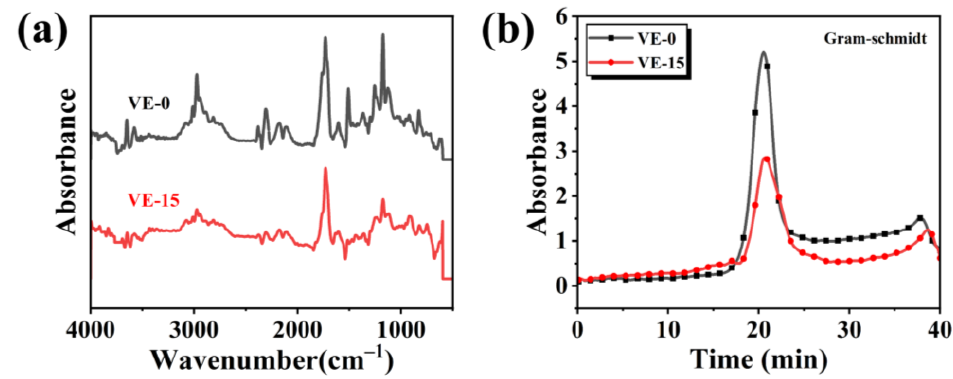
Figure 9. ( a ) FTIR spectra of pyrolysis gaseous products originated from VE-0 and VE-15 at the maximum evolution rate; ( b ) Absorbance intensities of VE-0 and VE-15.